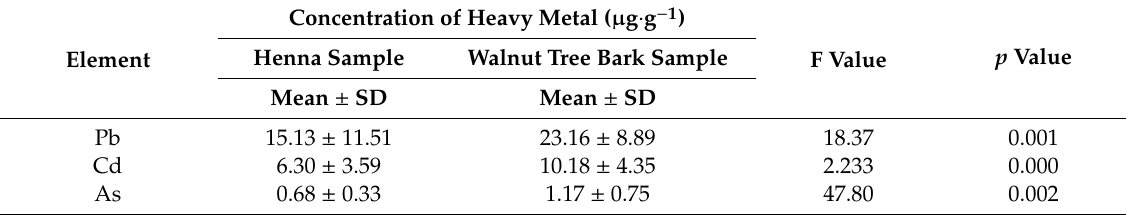
Table 8. Comparative between concentration levels of Pb, Cd and As in henna and walnut tree bark